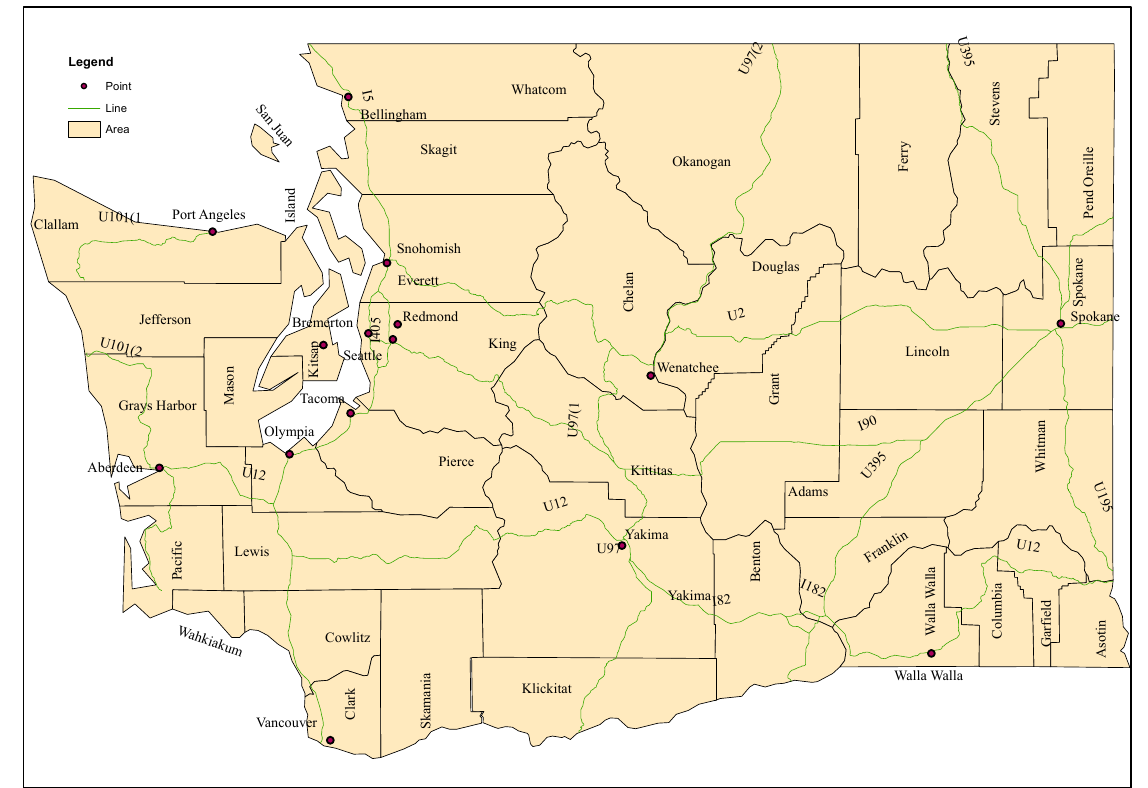
Figure 8. Result of the first dataset using the DDEGA-NM algorithm.